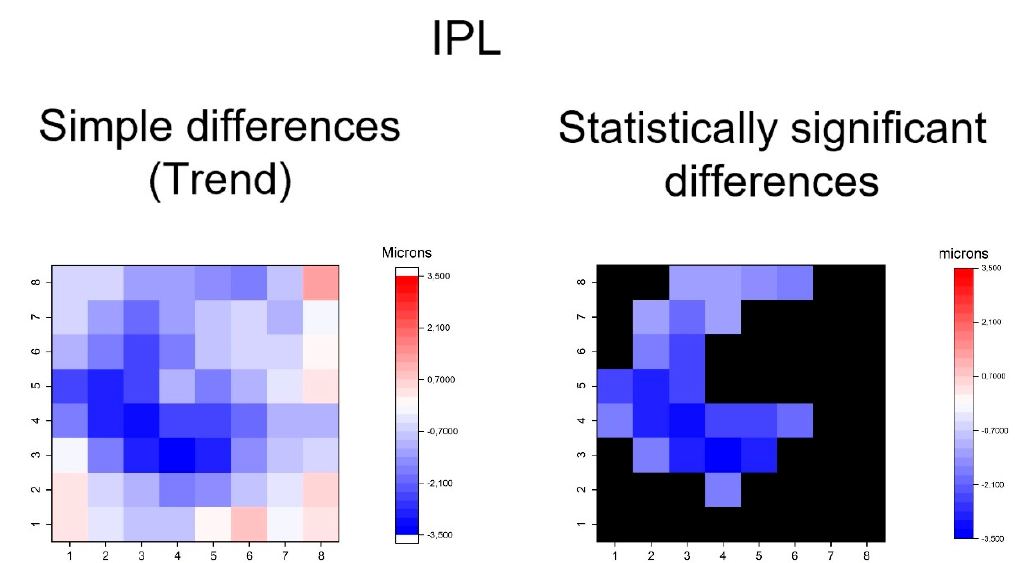
Figure 6. Heatmaps showing differences in inner plexiform layer (IPL). Left map: this heatmap represents simple differences of mean thickness between OHT group and early POAG group in each superpixel giving an idea of the trend. Right map: the heatmap represents statistically significant differences ( p < 0.05) of the mean thickness between groups in each superpixel. No significant difference ( p ≥ 0.05) is represented in black. Range of significant OHT ‐ POAG differences in superpixels between − 3.36 and − 1.22 microns.